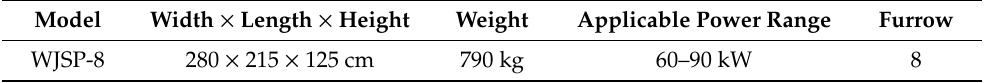
Figure 3. Tractor with a moldboard plow used in the field experiment during tillage operation. Table 1. Specifications of the moldboard plow used in this study.